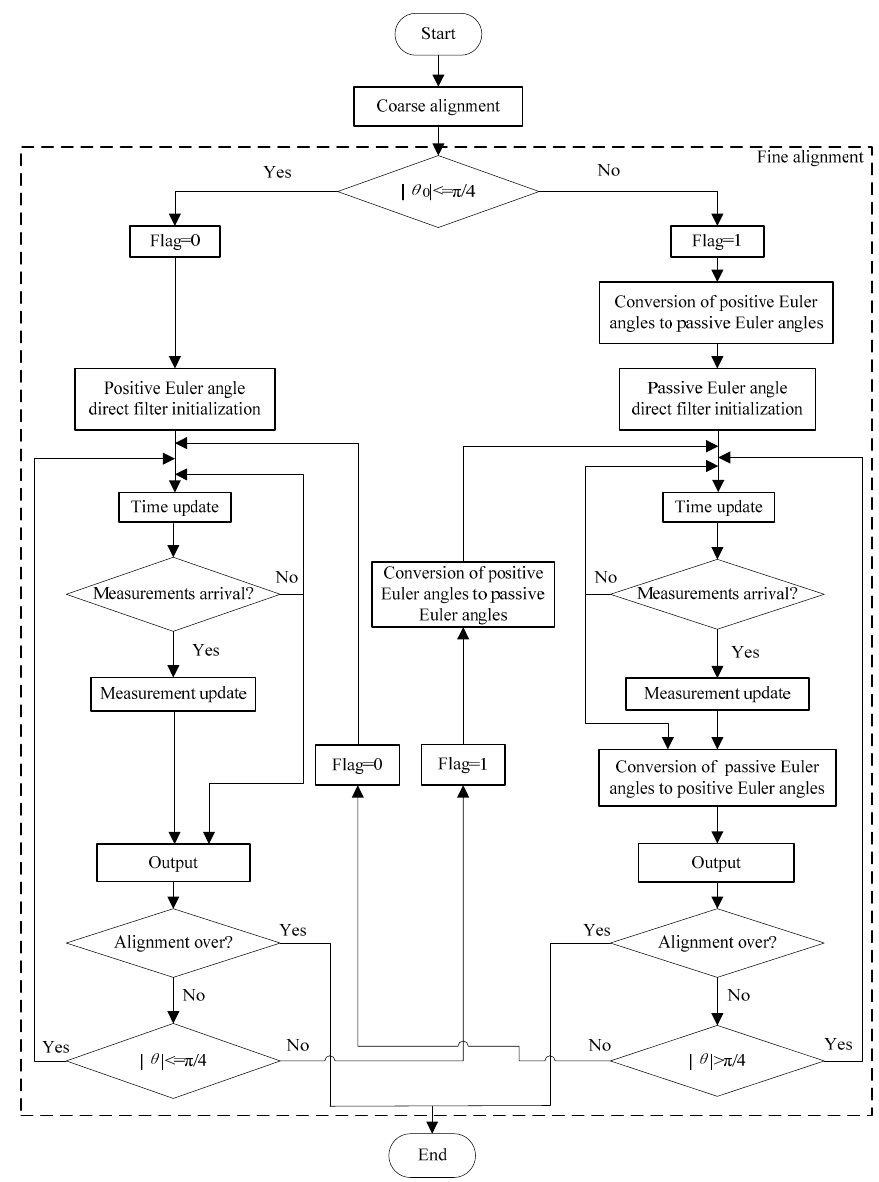
Figure 10. Flow chart of the SINS initial alignment using the dual-Euler direct approach.